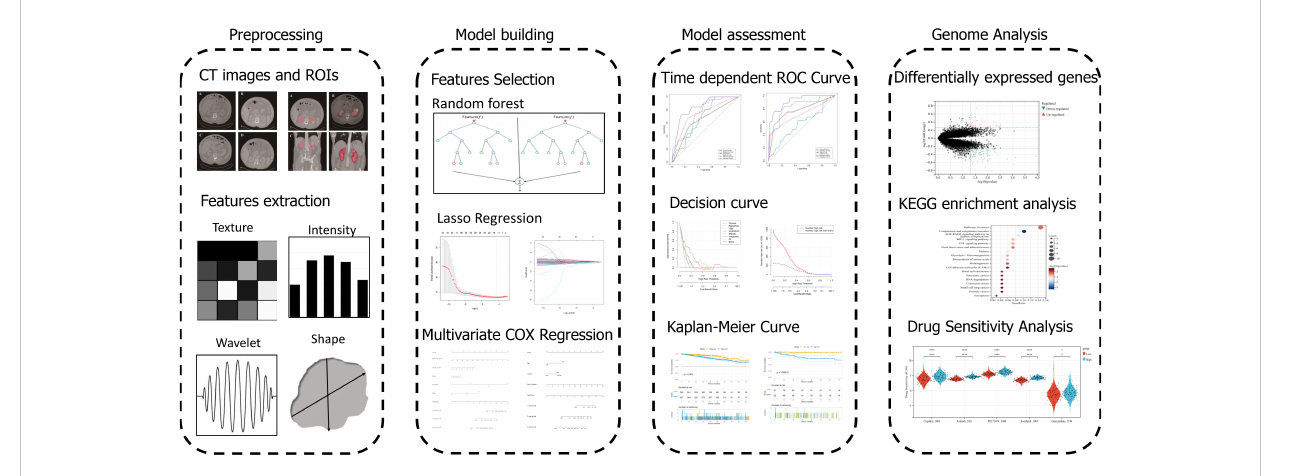
FIGURE 1 Graphical abstract of radiomics analysis and model